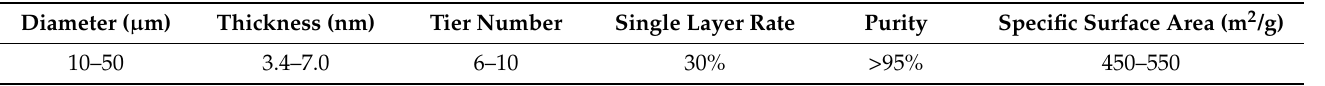
Table 1. Performance parameters of graphene.